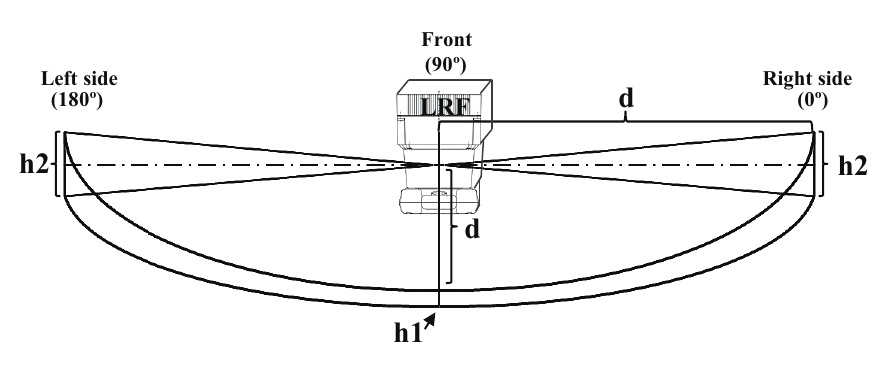
Figure 1. Diffuse feature of laser beam.